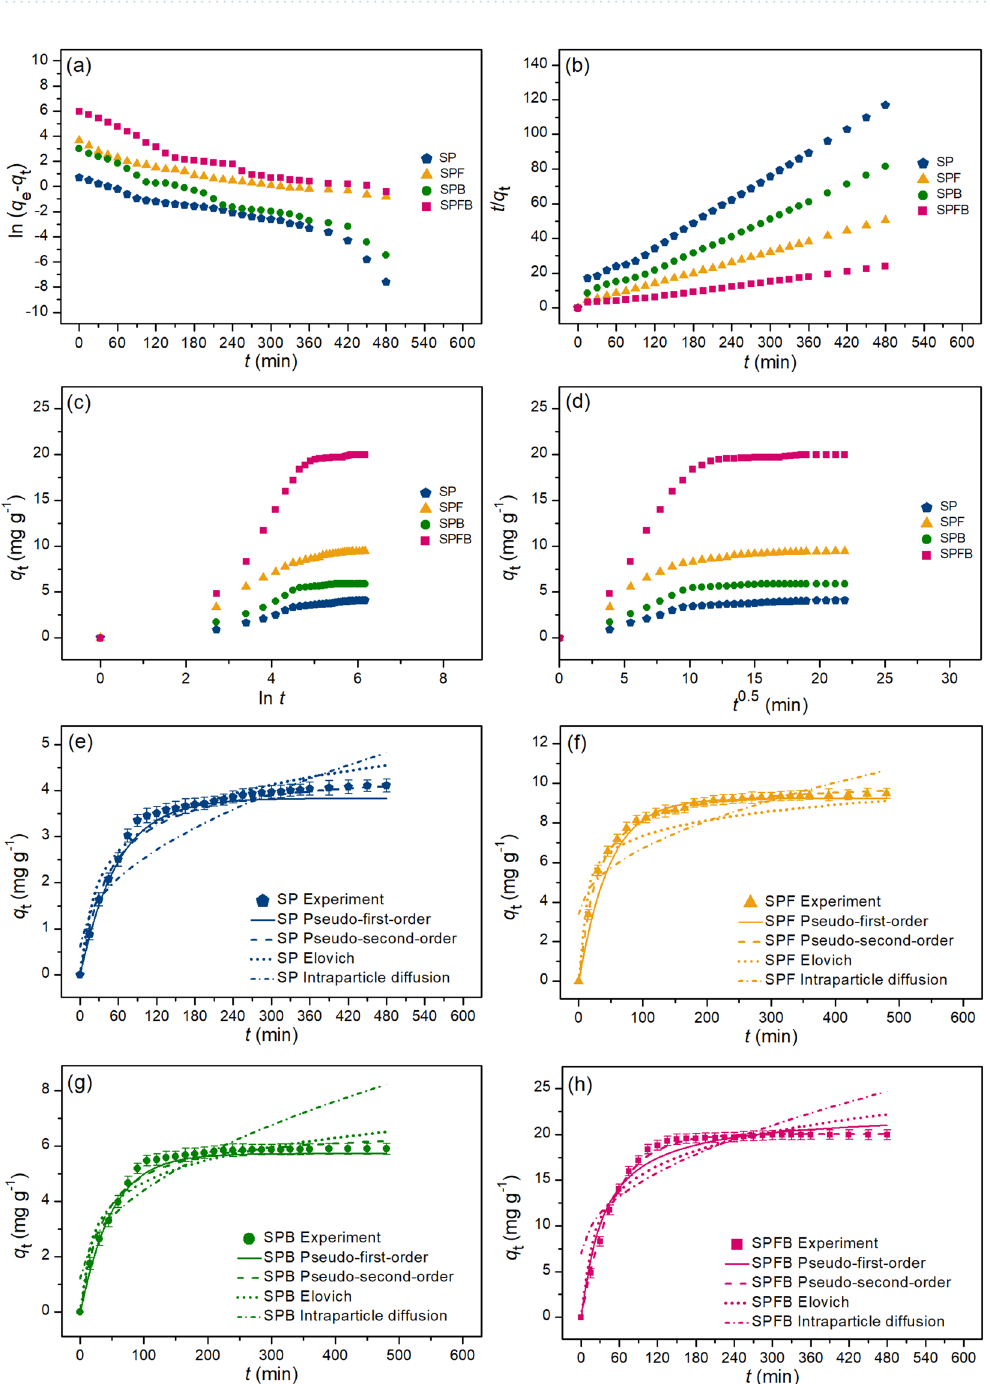
Figure 8. Graphs of ( a ) linear pseudo-first-order, ( b ) linear pseudo-second-order, ( c ) linear Elovich model ( d ) linear intraparticle diffusion, and ( e – h ) nonlinear kinetic models of sawdust powder (SP), sawdust powder doped iron (III) oxide-hydroxide (SPF), sawdust beads (SPB), and sawdust powder doped iron (III) oxide- hydroxide beads (SPFB) for lead